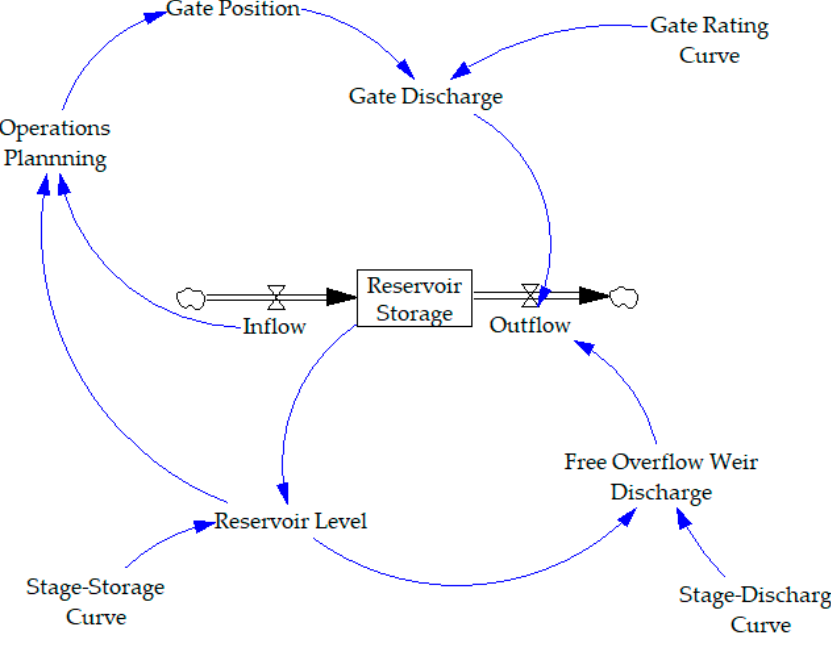
Figure 4. Simple dam system with a single weir and gate, with operations planning algorithm